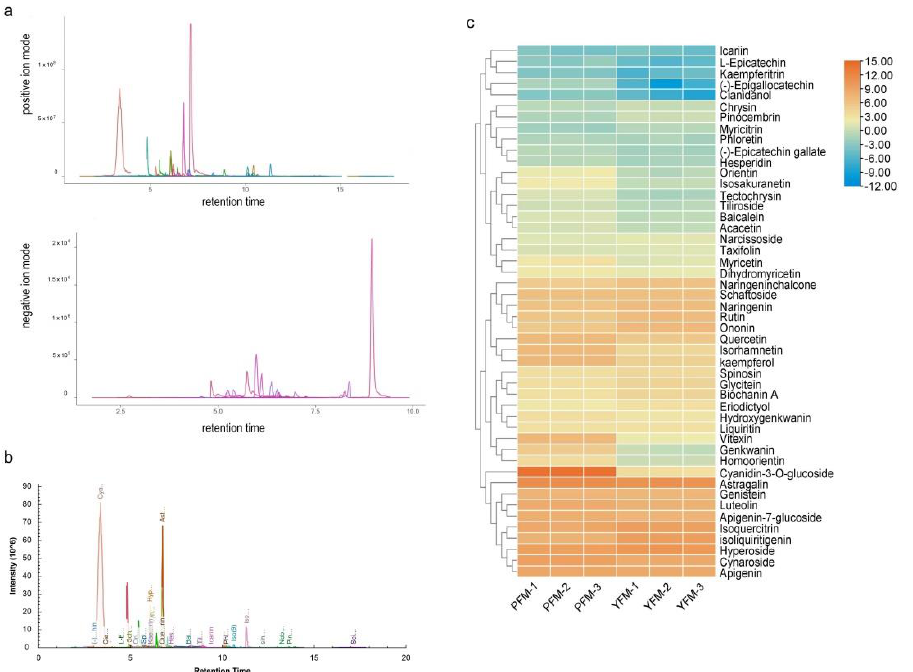
Figure 3. Identification of flavonoids in M. ruthenica species. The petal samples of PFM and YFM were collected during the flowering phase, and a total of three biological samples were taken, each from three independent plants that were used in the experiment. To determine the total flavonoids, extraction and targeted metabolite profiling were performed by Ollwe gene Technologies Co., Ltd. (Nanjing, China). ( a , b ) Ultra-performance liquid chromatography–tandem mass spectrometry (UPLC-MS) analysis of anthocyanins and flavonoids in flower samples of PYM and YFM. UPLC was performed by XCIEX AD system (AB Sciex, Framingham, MA, USA), and MS performed by QTrap 6500 (AB Sciex, Framingham, MA, USA), UPLC was used for component separation in samples, MS was used for signal acquisition and these separated components’ identification. The signals of these DAMs were acquired and identified in both positive ion mode and negative ion mode ( a ). Forty-eight DAMs were screened based on PCA and OPLS-DA ( b ). In this figure, each peak represents a kind of anthocyanin or flavonoid. The contents of anthocyanins and flavonoids were calculated using the area of related peak. ( c ) Heatmap of differentially accumulated flavonoid metabolites (DAMs) in PFM and YFM. A heatmap was drawn with TBtools using log 2 fold-change values of the concentrations of these 48 DAMs. Each line presents the color group representing related metabolites, which are listed on the right. The colors reflect the contents of metabolites, cells with orange-color represent high accumulation in samples, and the color scale from blue to red represents low to high accumulation in samples, respectively. PFM − 1–3 and YFM − 1–3 represent the three biological independent PFM and YFM samples, respectively. In this study, PFMs served as the control